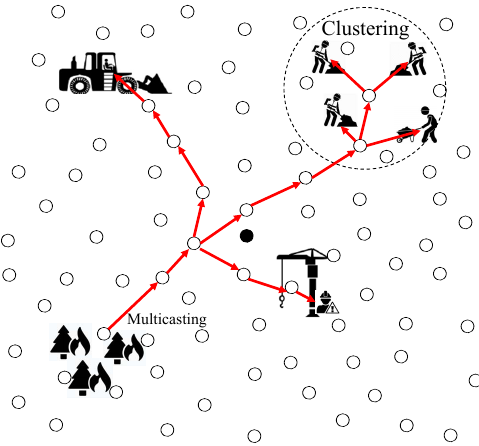
Figure 1. An overview of proposed